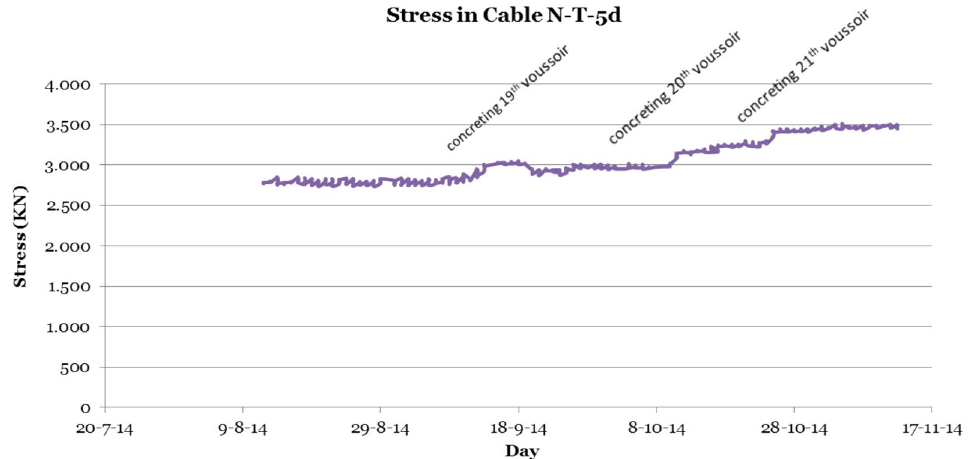
Figure 13. Monitoring of the evolution of the stresses in the right-hand retaining cable belonging to the fifth family of temporary cables of the northern half arch of the Tajo River Viaduct (N-T-5d) using a piezoelectric accelerometer.